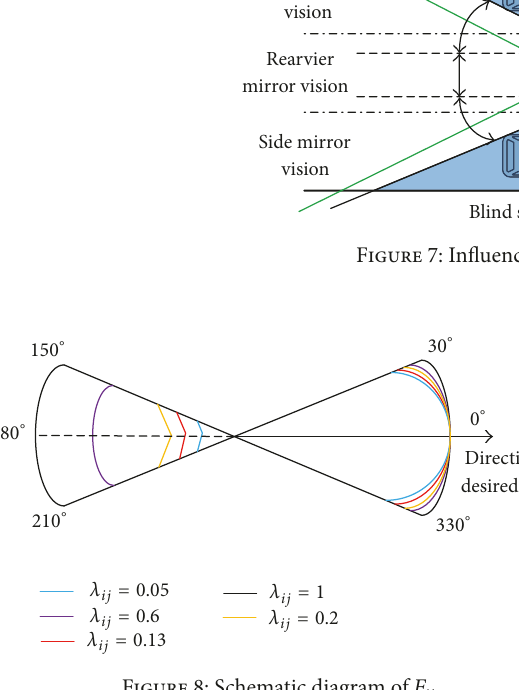
Figure 8: Schematic diagram of 𝐹 𝑖𝑗